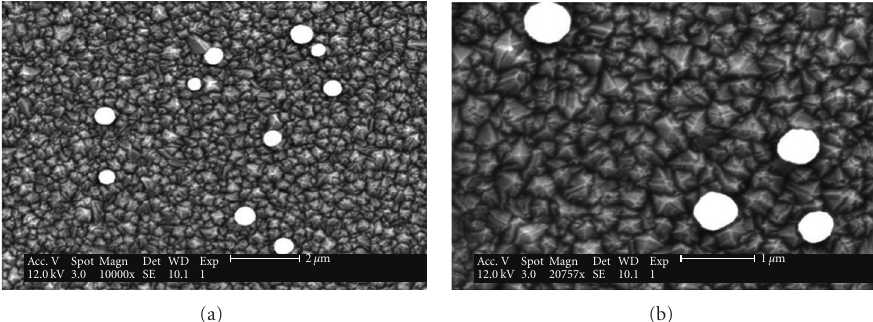
Figure 4: SEM images at two di ff erent magnification scales of a BDD-Pt electrode prepared by electrodeposition with a single potential step